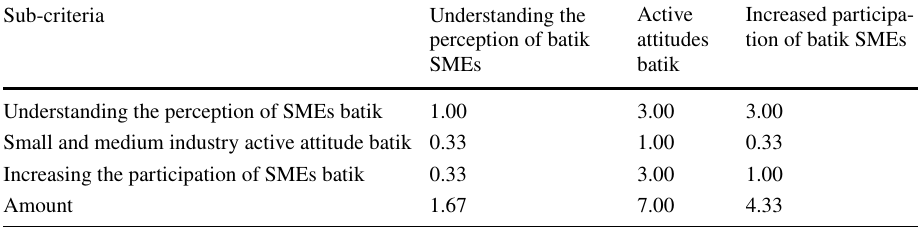
Table 8 Matrix comparison of sub-criteria